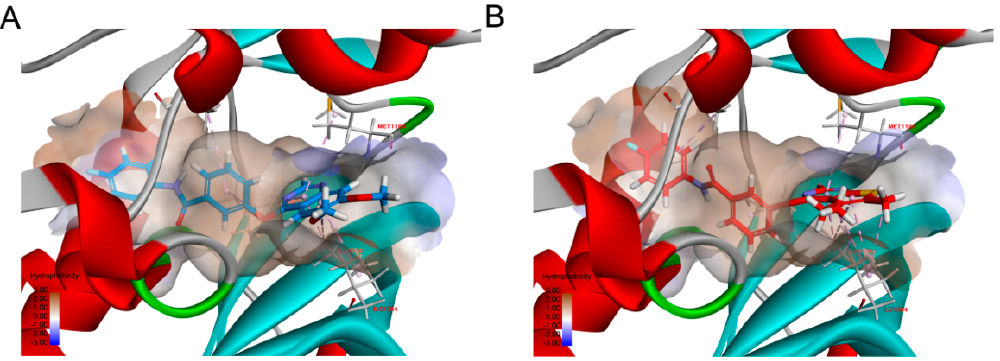
Figure 2. Binding poses of compound 11c ( A ) and 11i ( B ) with c-MET. Compound 11c and 11i were displayed by blue and red, respectively. The important residues and their critical interactions (dash lines) with compounds in the binding site were depicted, hydrogen bond, hydrophobic interactions were colored green and carnation, respectively.